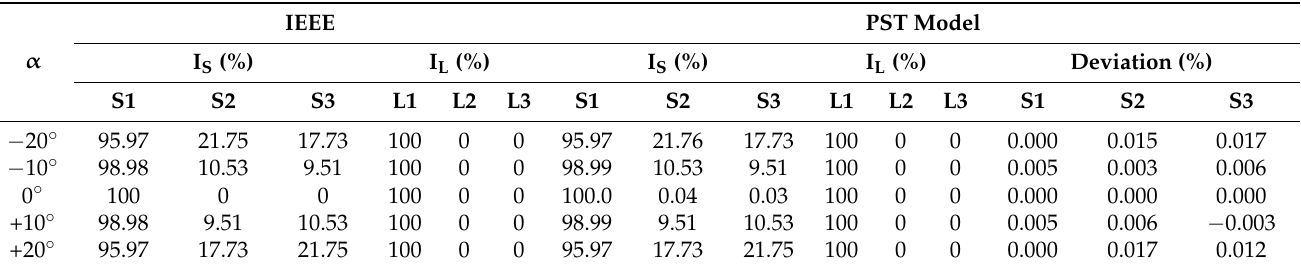
Table 4. Short circuit currents contribution for phase-to-ground fault scenario